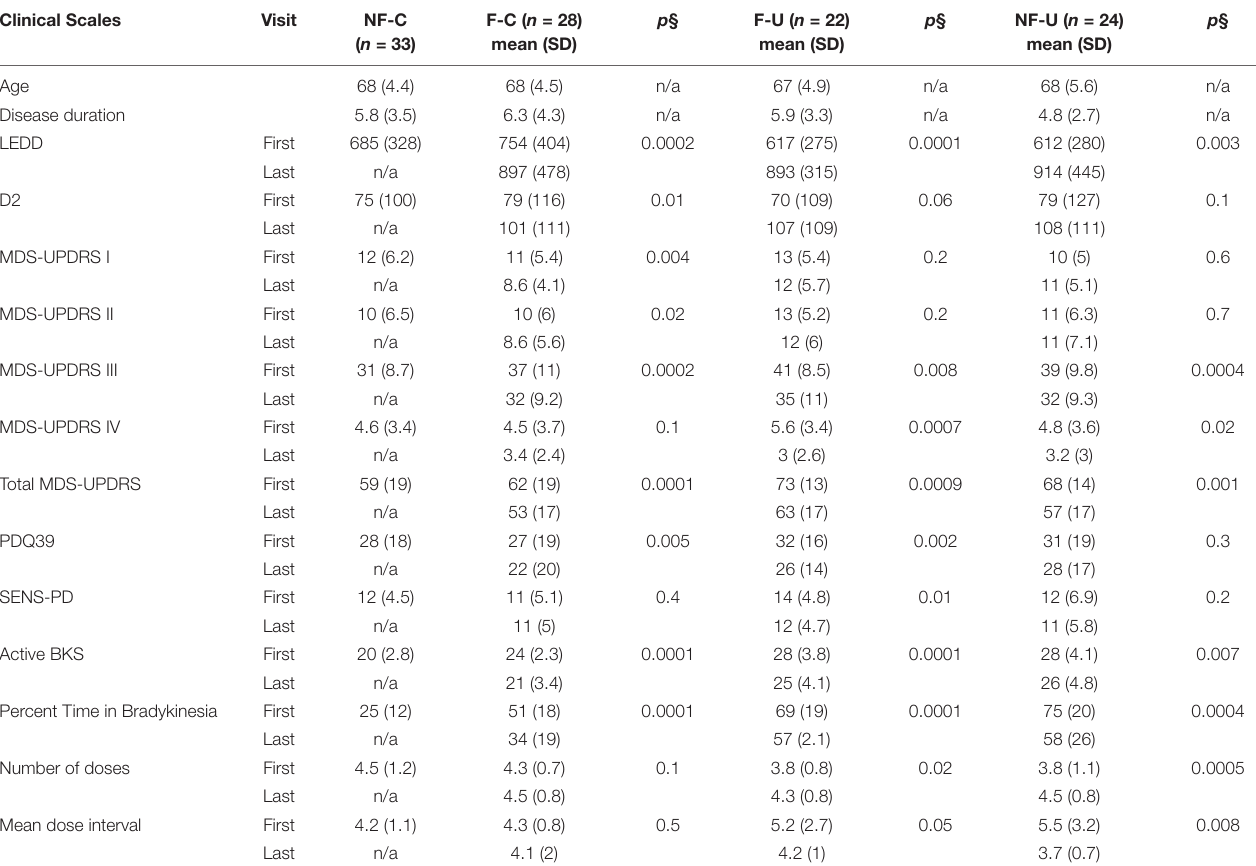
TABLE 1 | Comparison of clinical and PKG scores before and after treatment optimization in fluctuator subclasses including cases from both PKG + and PKG- arm. Clinical